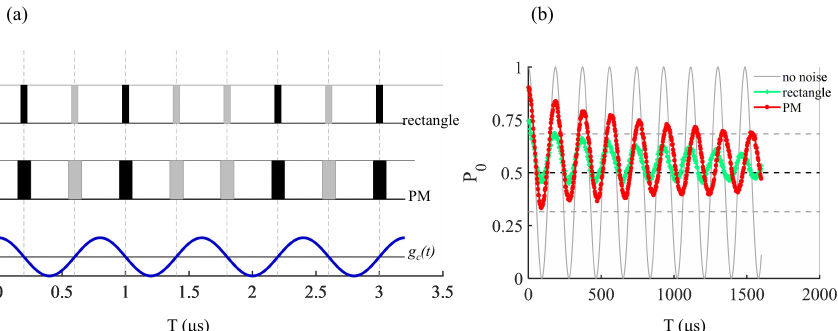
Figure 6. ( a – c ) Optimization results obtained with the B-PM method with N D = 1 and n = 9. ( d – f ) Optimization results obtained with the SFB method with N D = 2 and M × N = 16. ( a , d ) Optimization values of objective function of 100 trials with random initial parameters λ . ( b , e ) Shape of the optimized control field in the interaction picture. ( c , f ) Fidelity distribution in regions δ ∈ 2 π × [ − 10,10 ] MHz and κ ∈ [ 0.5,1.5 ] .